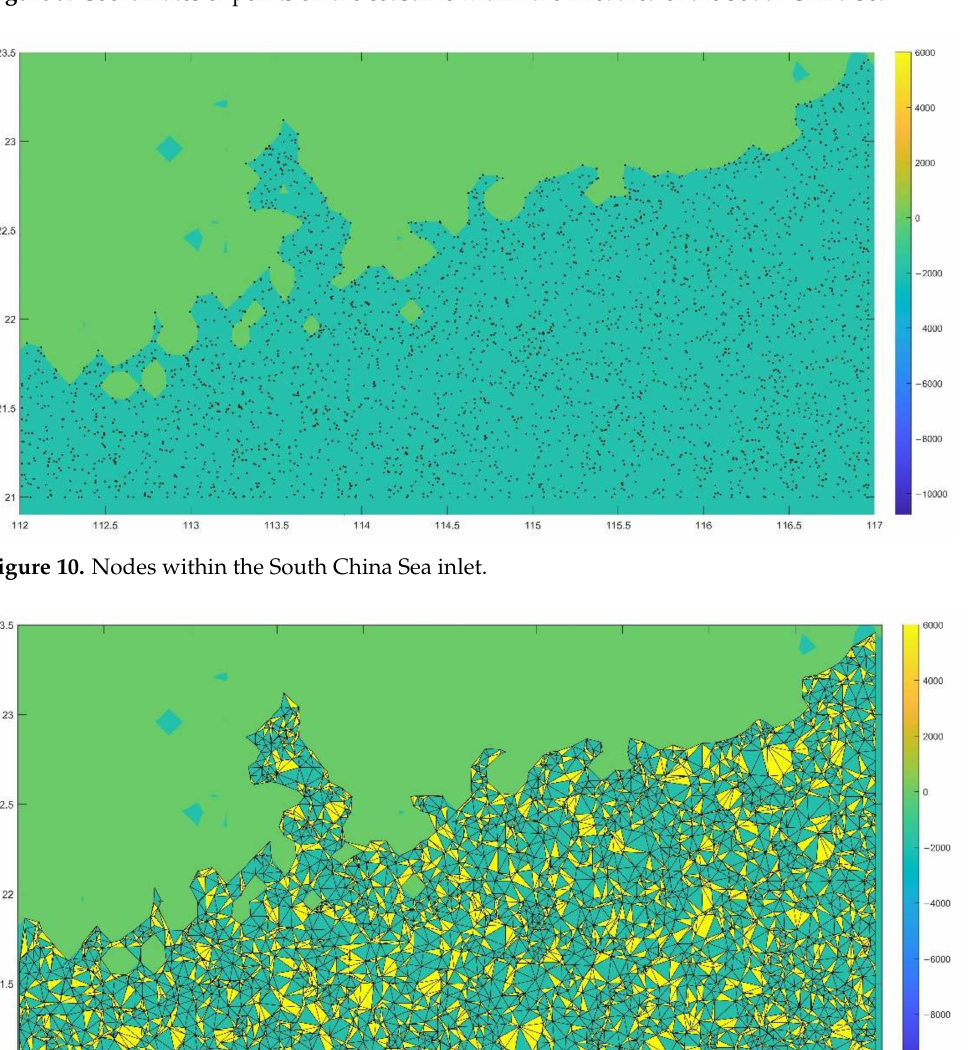
Figure 9. Coordinates of points on the coastline within the inlet area of the South China Sea.